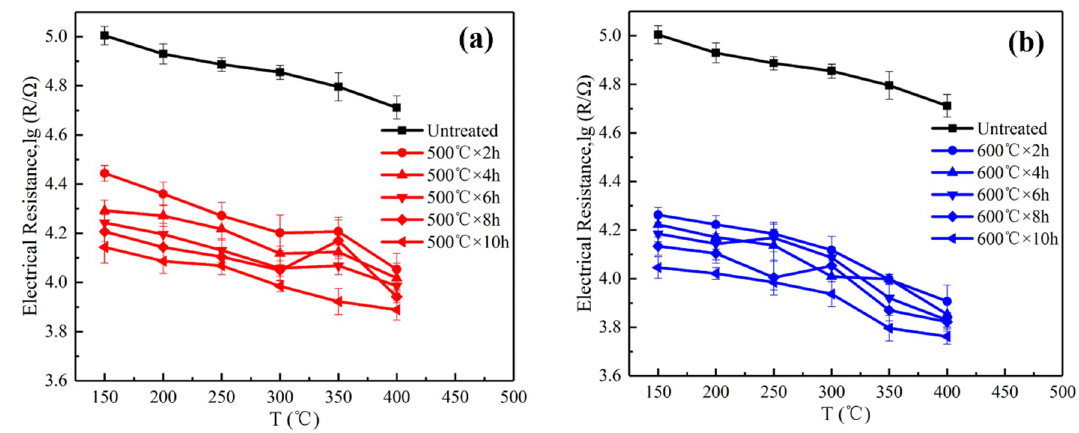
Figure 9. The electrical resistances of the sensors CVD treated at ( a ) 500 ◦ C and ( b ) 600 ◦ C as a function of temperature in air.